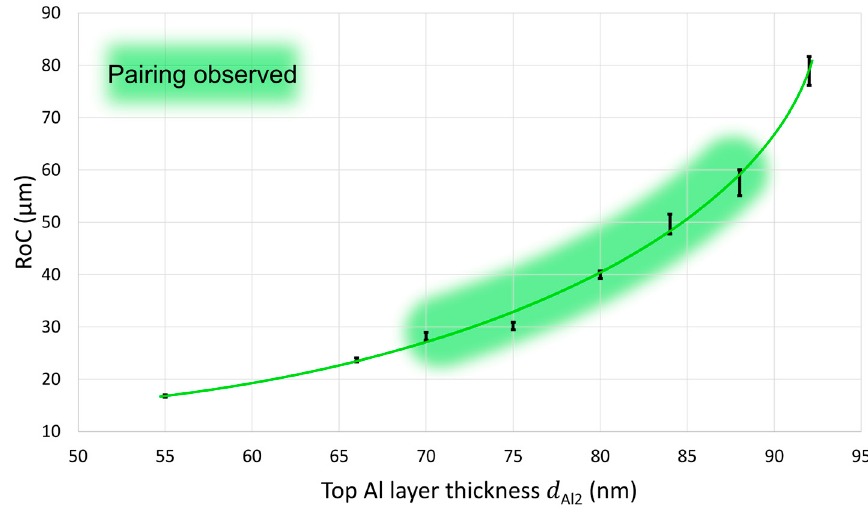
Figure 6. The measured radius of curvature (RoC) of the curled shutter blades as a function of the thickness of the top Al layer ( d Al2 ). The highlighted region refers to the thicknesses values that show pairings.